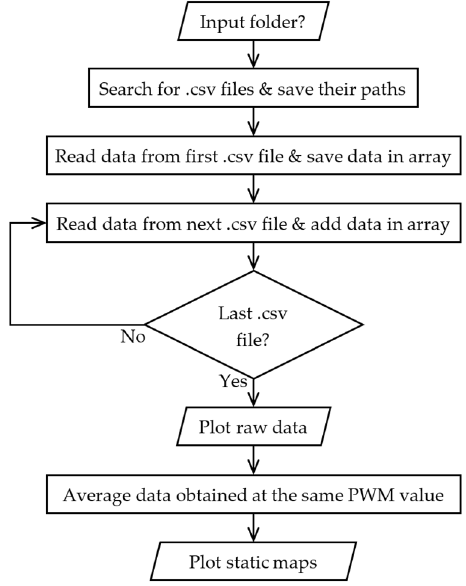
Figure 6. MATLAB script flowchart.